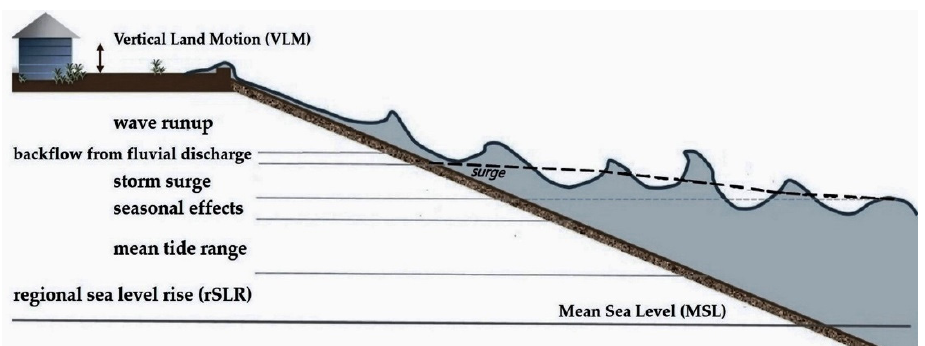
Figure 2. Dynamic water level concept (adapted from reference [36], Figure 1 in Dynamic flood modeling essential to assess the coastal impacts of climate change (2019). Barnard et al., Sci Rep 9,